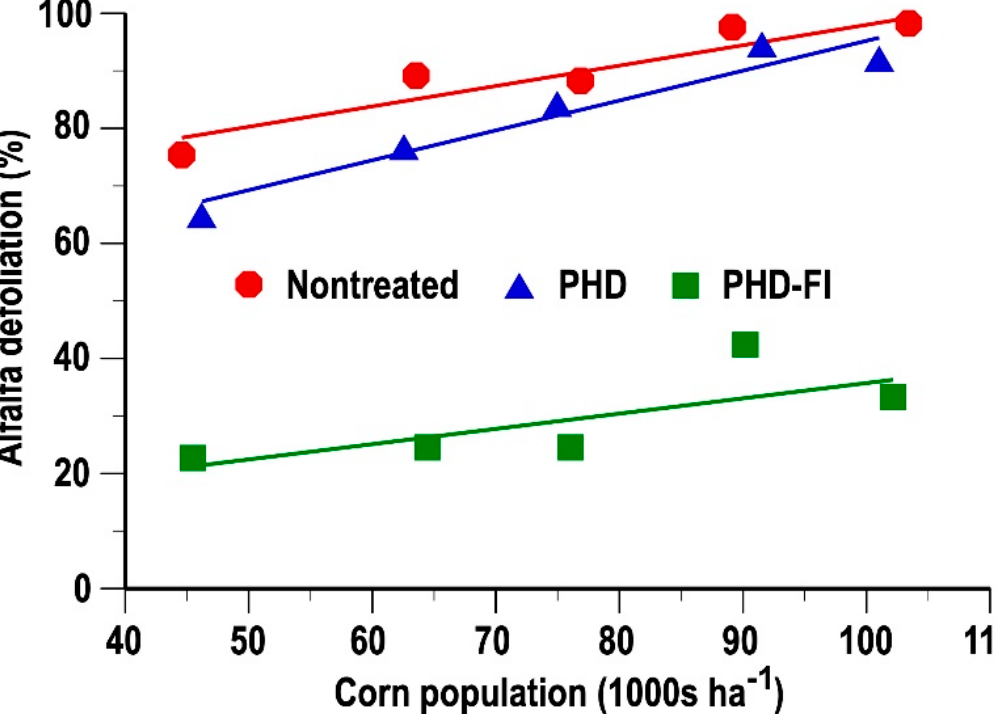
Figure 4. Defoliation of alfalfa four weeks after fungicide and insecticide application as affected by corn population and agrichemical treatments. Agrichemical treatments applied to alfalfa during establishment consisted of a nontreated control, prohexadione (PHD), and prohexadione, followed by fungicide and insecticide (PHD-FI). Data were averaged across alfalfa varieties and production years. Regression intercepts and slopes differed between agrichemical treatments ( p =